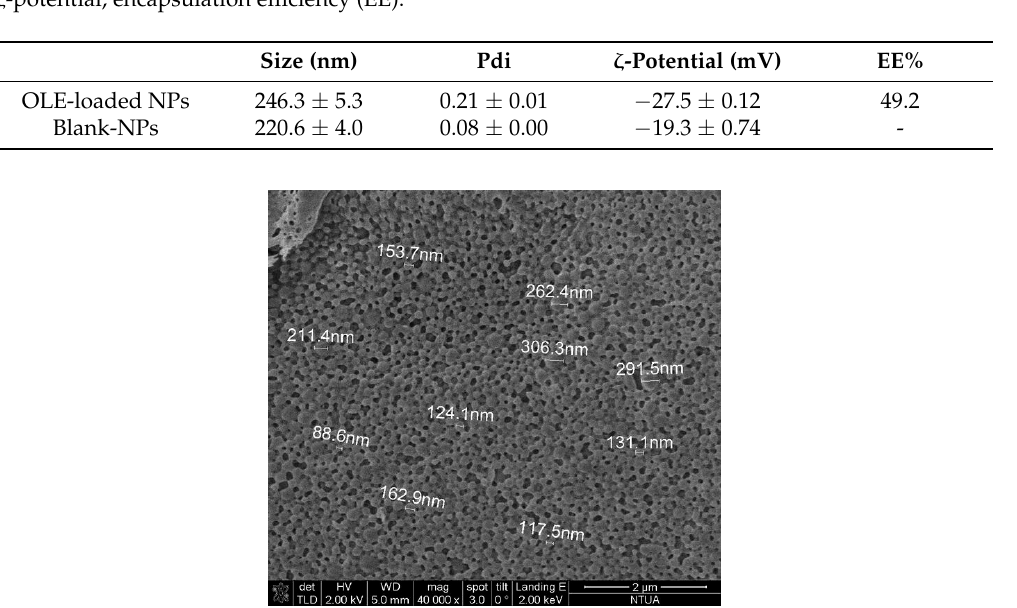
Figure 3. HPLC chromatogram of olive leaves extract (OLE). The peaks that were identified are: 1 oleuropein, 2 vanillin and 3 rutin. The UV-VIS spectra corresponding to the main polyphenols components are shown above the chromatogram.